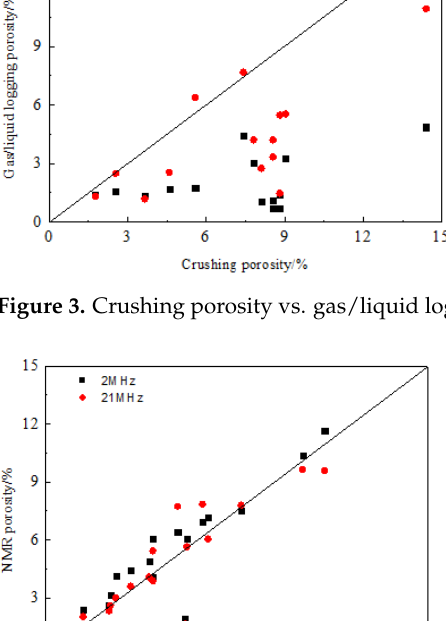
Figure 5. Shale NMR at 2 MHz. Figure 6. Shale NMR at 21 MHz.